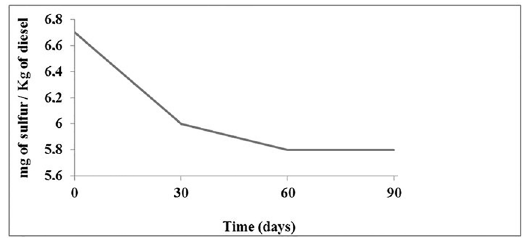
Figure 2. Total sulfur content in the S10 Diesel samples in contact with water.